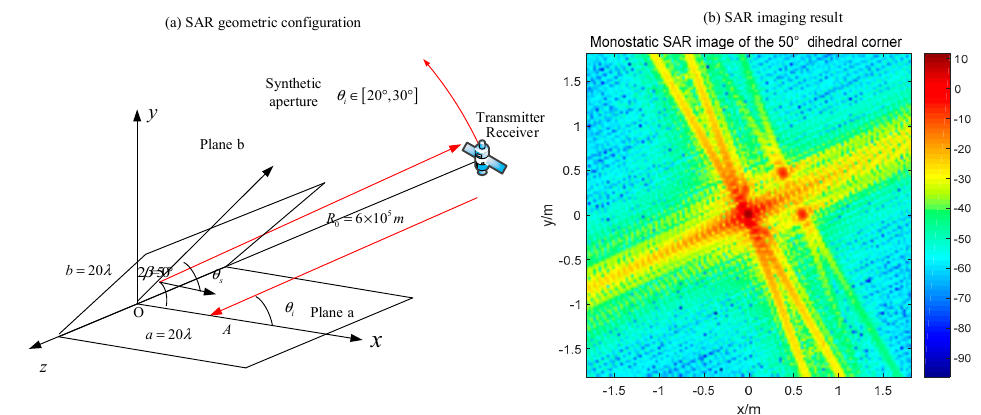
Figure 24. Monostatic SAR image of a 50° dihedral corner ( a ) geometric configuration; ( b ) imaging result.